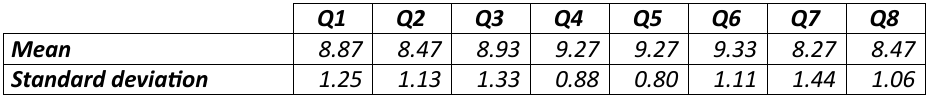
Table 1. Results of the post-actvity survey